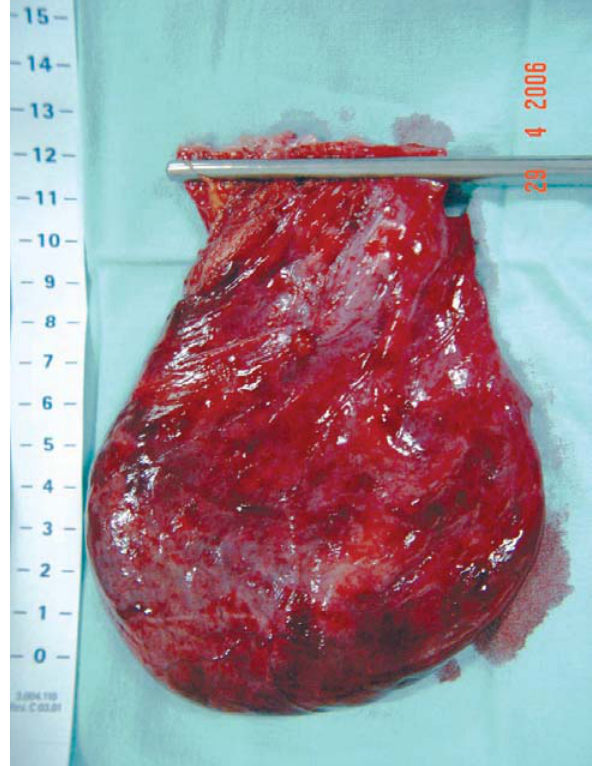
Fig. 2 - Aspecto macroscópico do cisto pericárdico